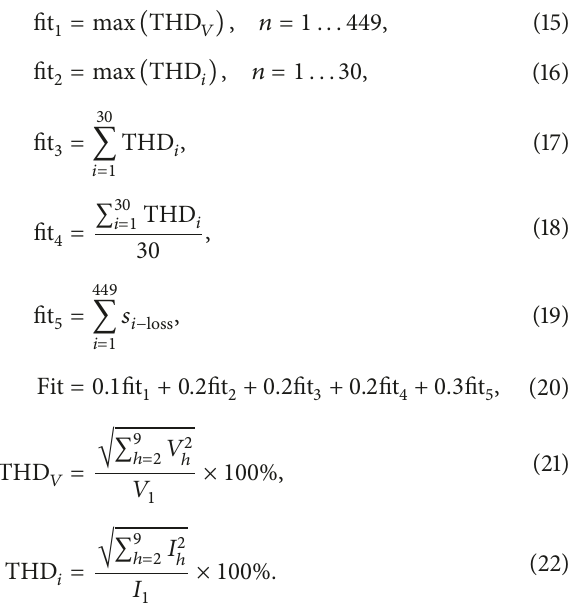
Figure 7: Flowchart to evaluate